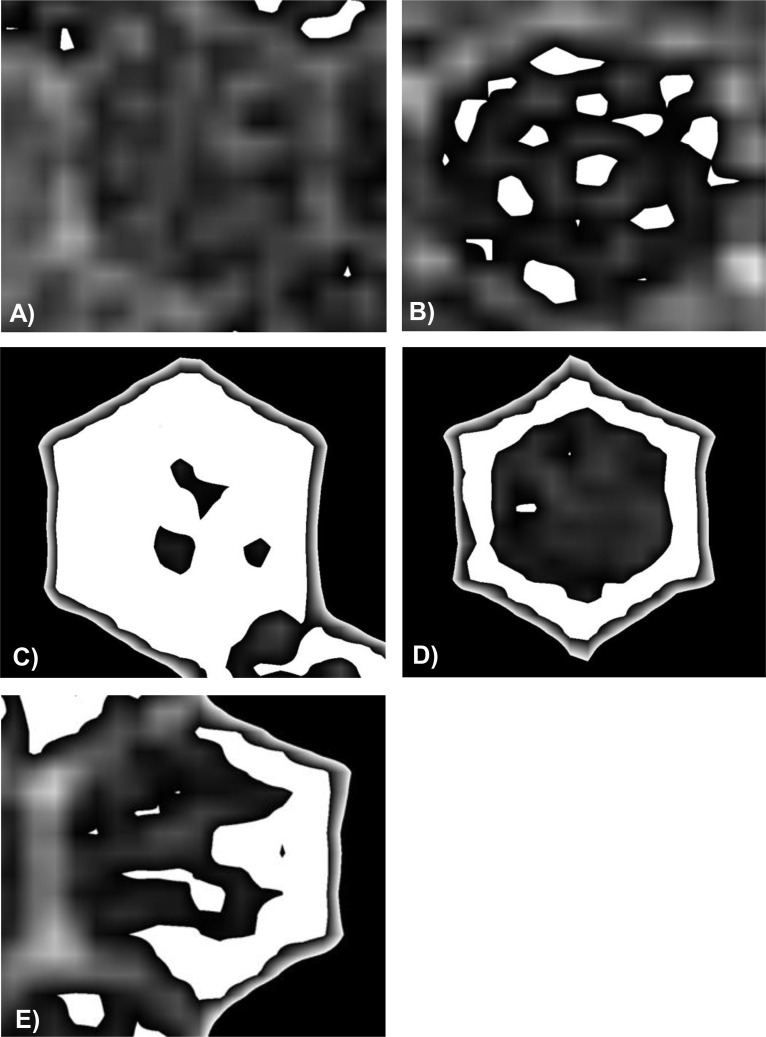
Patterns of content appearance observed in individual cells at day 1.A) dark cell content of low density, B) cell content contains a variable number of high density speckles of varying sizes, C) most of the content of bright cells is of high density, D) the high density content coats all or E) some of the walls.